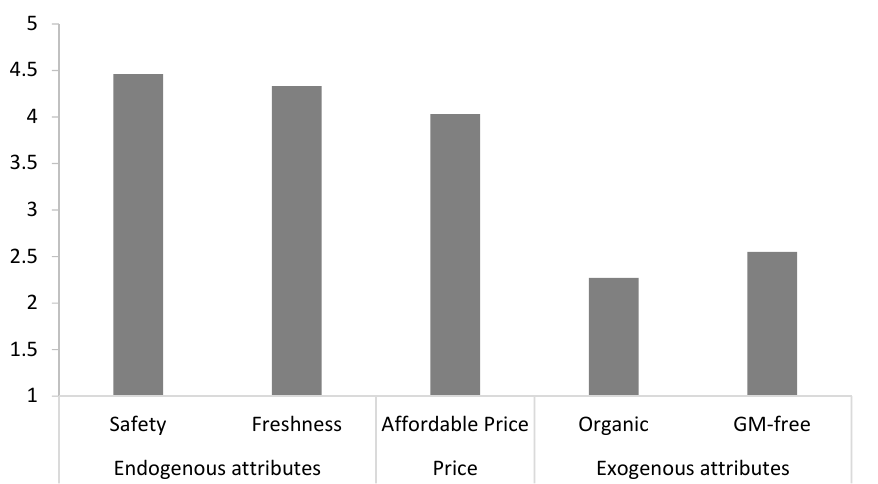
Figure 1. Reported importance of food attributes (1 = not important at all, 5 = extremely important). Table 2. Latent profile fit statistics for attribute preference model with one to four profiles.